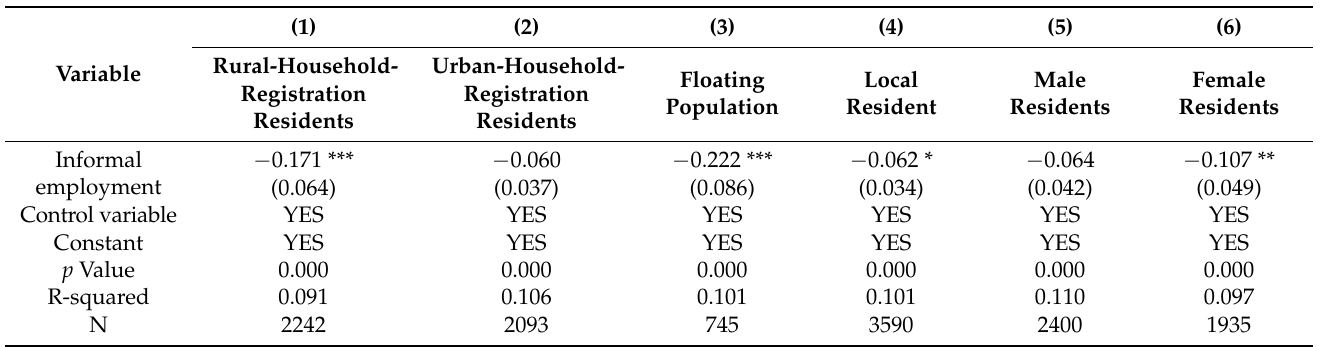
Table 3. Regression results of